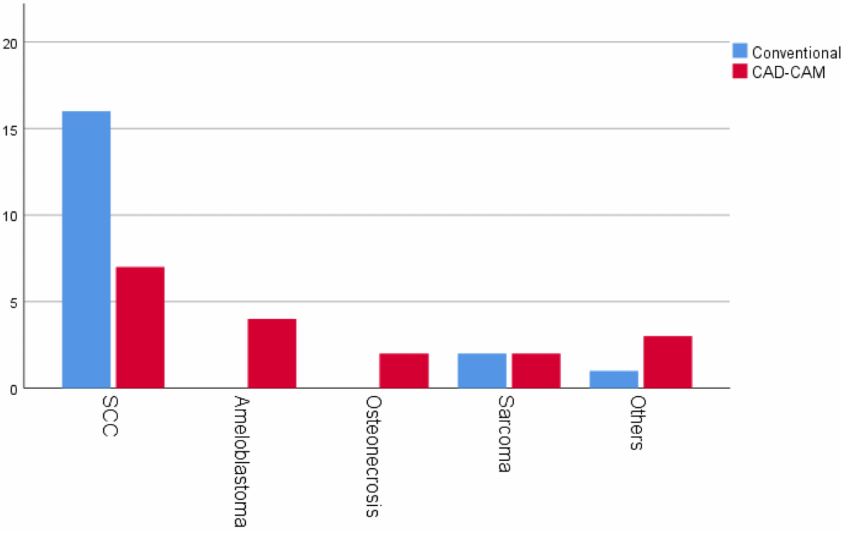
Figure 1. Diagnoses. SCC (squamous cell carcinoma).